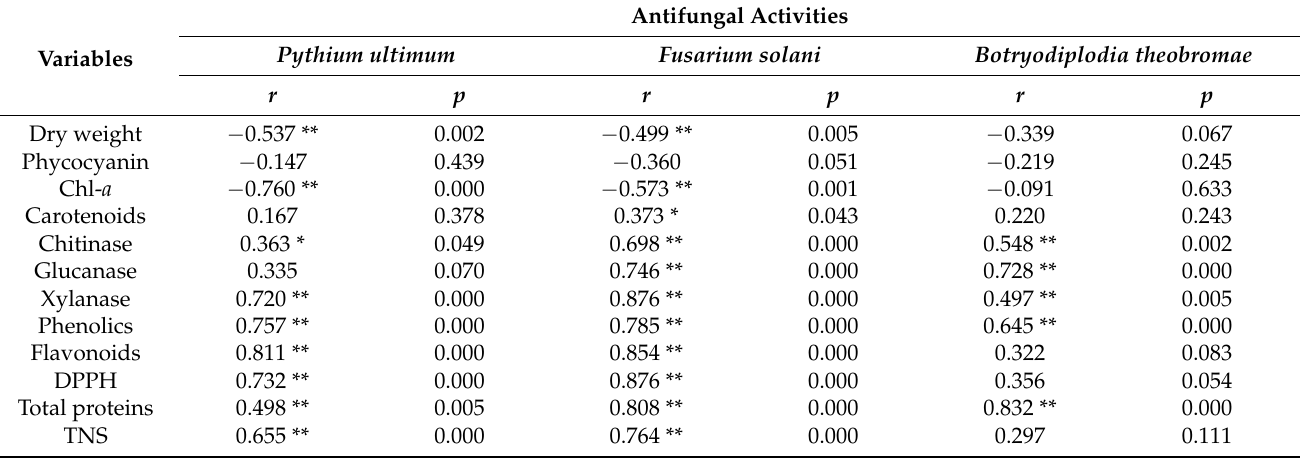
Table 1. Pearson’s correlation matrix represents the interrelationship between variables. The correla- tion was followed by a two-tailed significance test at the 0.05 level.